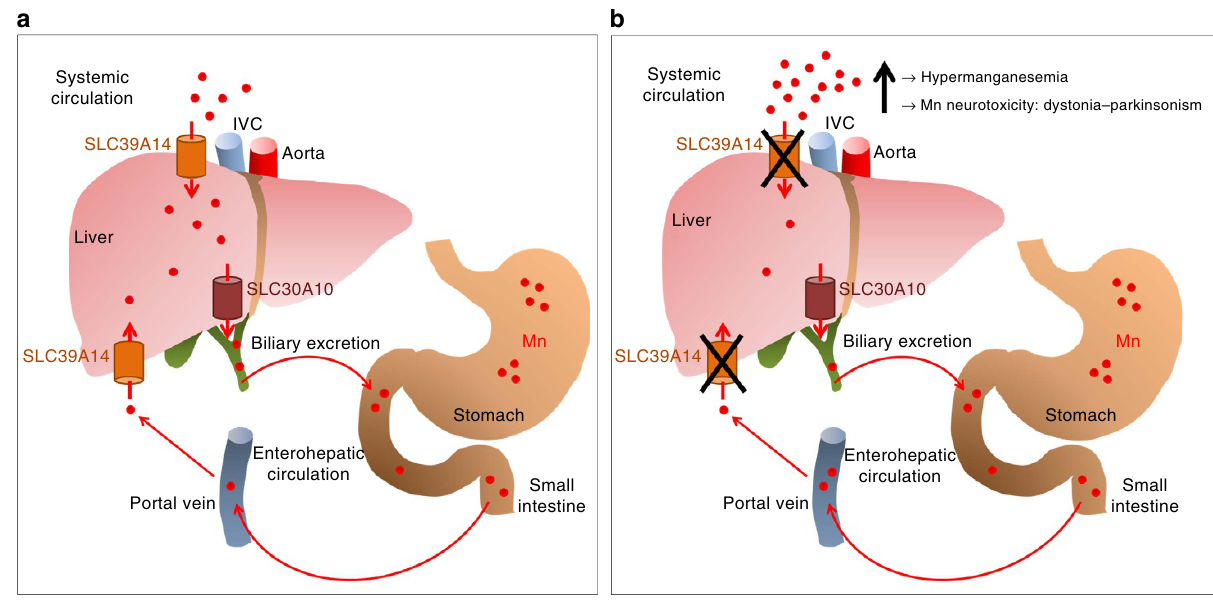
Figure 8 | Proposed disease mechanism in patients with SLC39A14 mutations. ( a ) Under normal conditions nutritional Mn (red) is absorbed in the duodenum and enters the enterohepatic circulation via the portal vein from which it is transported into the liver via SLC39A14, a Mn uptake transporter (orange). Any excess Mn is rapidly removed from the systemic circulation by uptake into the liver via SLC39A14 and excreted into the bile via SLC30A10 (brown), a Mn efflux protein. ( b ) Dysfunction of SLC39A14 (indicated by a black X) impairs hepatic uptake of Mn for subsequent biliary excretion. Consequently, Mn accumulates in the blood and brain leading to hypermanganesemia and neurotoxicity, respectively. IVC, inferior vena